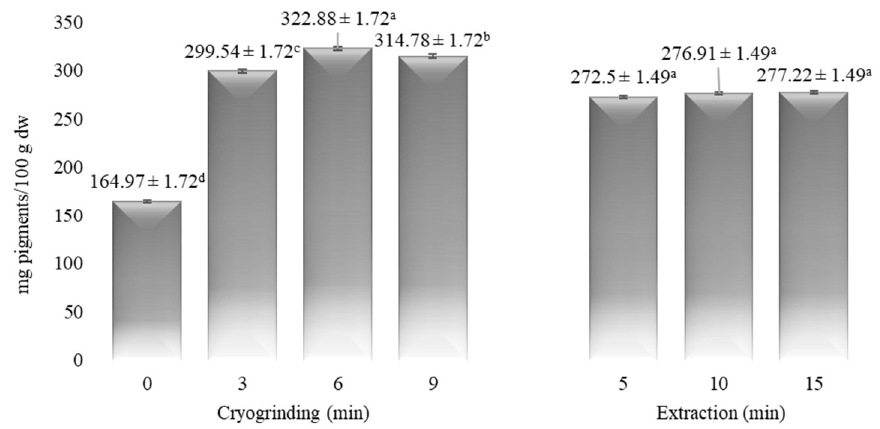
Figure 3. Influence of cryogrinding and extraction time on total pigments. Results are expressed as mean (n = 8 for cryogrinding time and n = 6 for extraction time) ± SE. Different letters indicate significant differences between the means ( p ≤ 0.05).